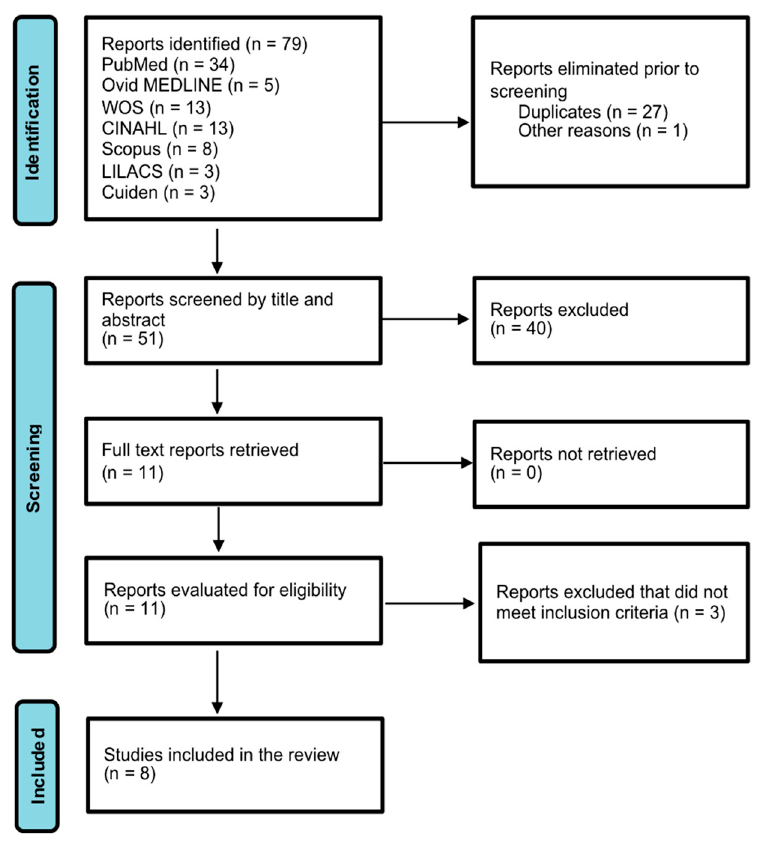
Figure 1. Flow diagram. Table 1. Author, Year, Journal, Country, Methodology and Study